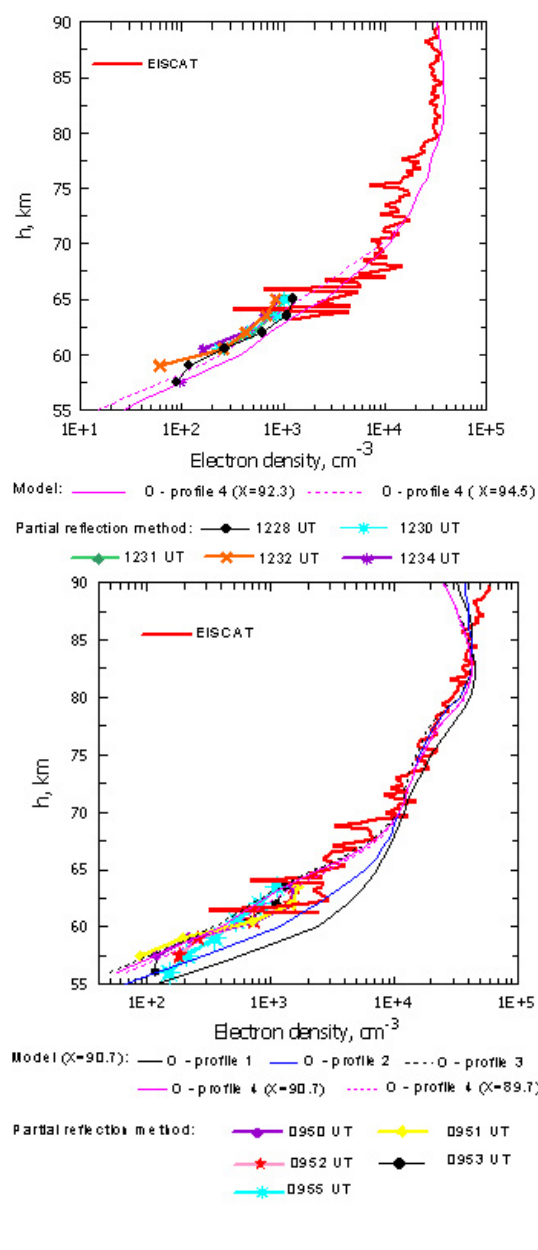
Fig. 7. Electron density profiles on 17 January 2005 at 09:50UT and 12:30UT. Upper panel: the N e -profile measured with EISCAT radar ( χ =90.7 ◦ ) is shown by red line; N e -profiles measured with the par- tial reflection method ( χ =89.7 ◦ ) are shown by lines with symbols; model N e -profiles ( χ =90.7 ◦ ) based on O-profiles 1–5 are shown by solid lines without symbols. Lower panel: the N e -profile measured with EISCAT radar ( χ =92.4 ◦ ) is shown by red line; N e -profiles measured with the par- tial reflection method ( χ =94.5 ◦ ) are shown by lines with symbols; model N e -profiles based on O-profile 4 are calculated for χ =92.3 ◦ (solid line) and χ =94.5 ◦ (dotted